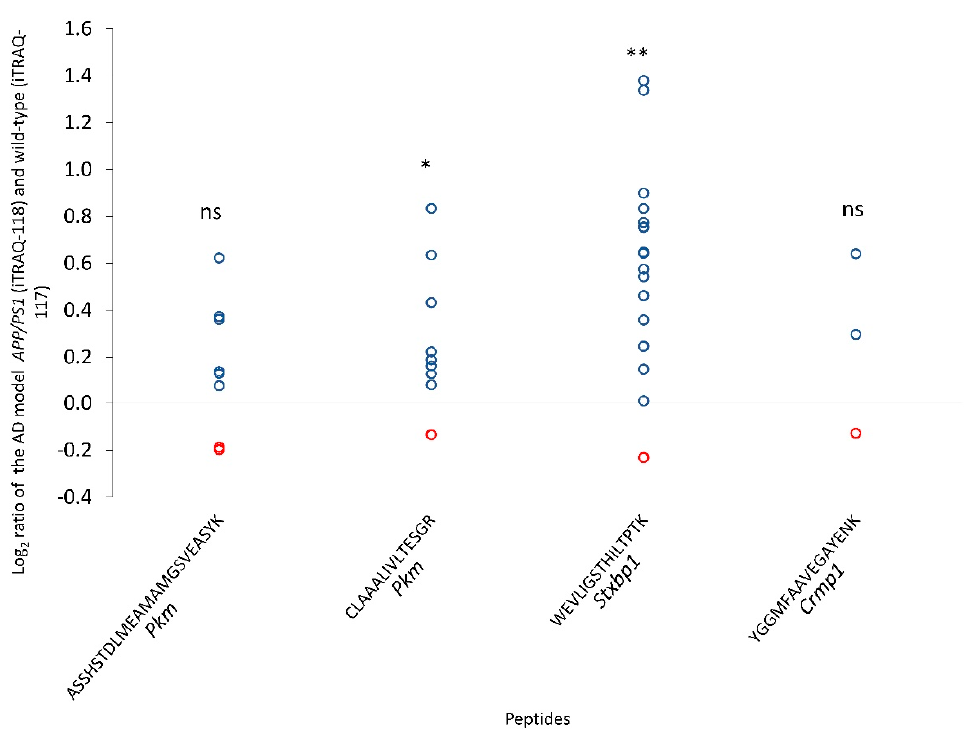
Figure 4. Log 2 ratio of the normalized intensities of the AS proteoform peptides (genes Pkm , Stxbp1 and Crmp1 ). Samples more abundant in the wild-type (log 2 ratio < 0) are represented as red dots and samples more abundant in the AD model APP/PS1 (log 2 ratio > 0) are shown as blue dots. One-sample t-test; not significant (ns), p -value < 0.05 (*) and p -value < 0.01 (**).